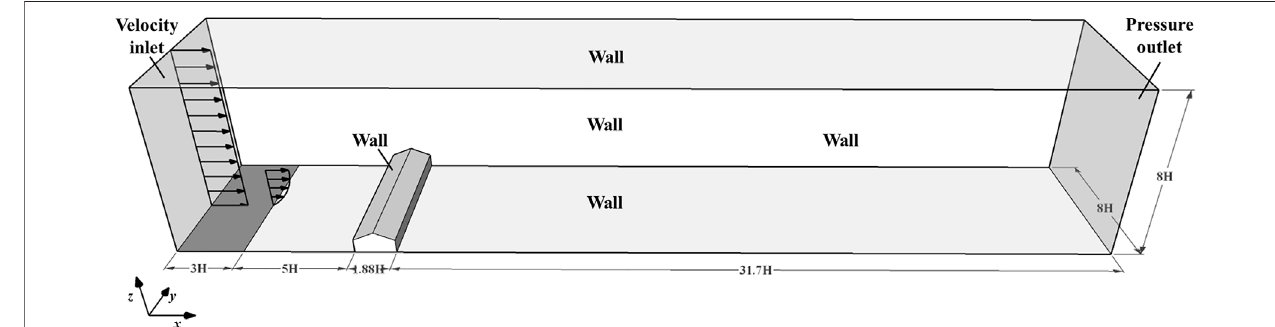
FIGURE 12 | Computational domain and boundary conditions.